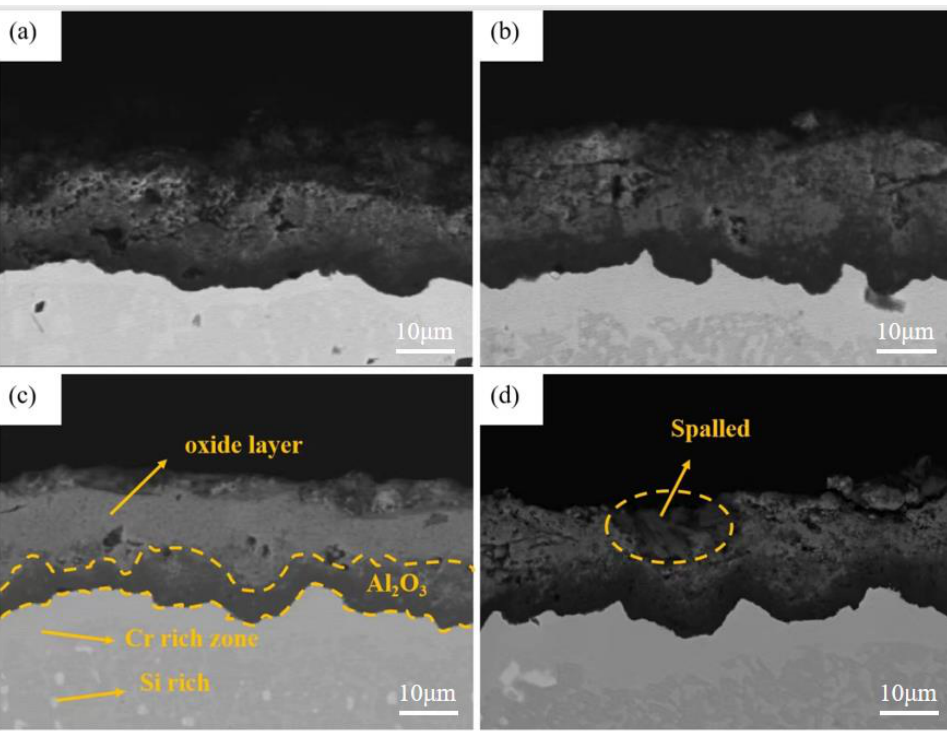
Figure 19. Cross-sectional morphologies of Al-Si coatings oxidized at 1000 °C for 300 h under dif- ferent pre-oxidation times: ( a ) 3 h; ( b ) 5 h; ( c ) 7 h; ( d ) 9 h. different pre-oxidation times: ( a ) 3 h; ( b ) 5 h; ( c ) 7 h; ( d ) 9